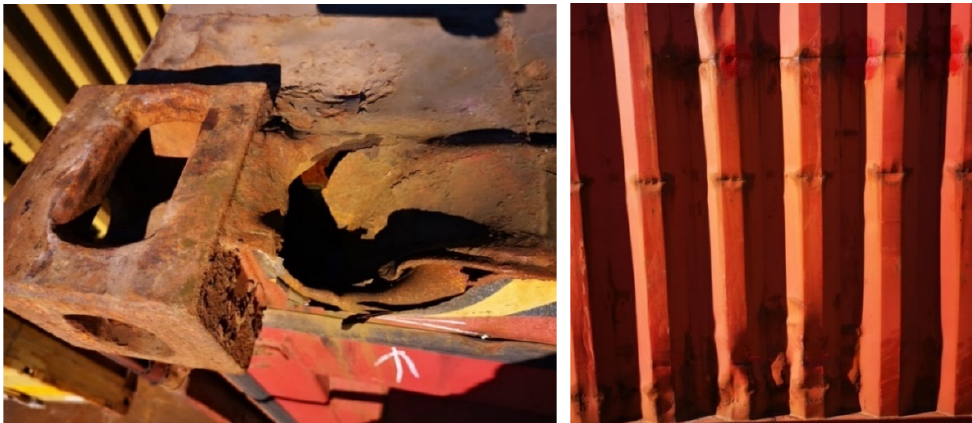
Figure 1. Examples of damaged containers due to external impacts.